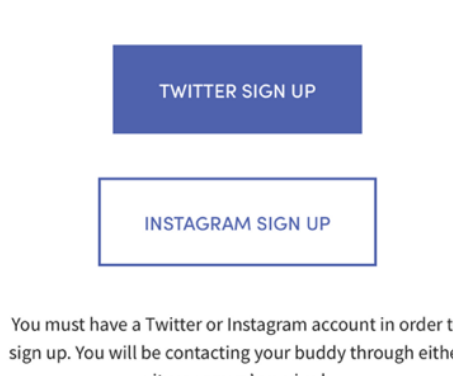
Figure 1. Buddy Project mission statements on Instagram biography.